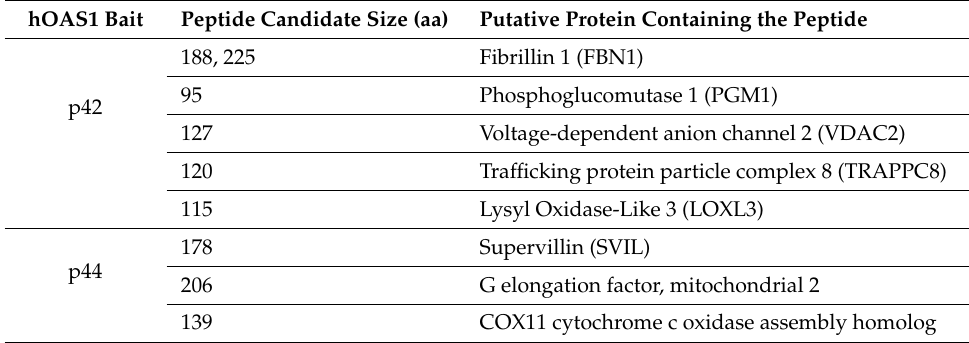
Table 1. Identification of peptide binding partners for the full-length hOAS1 p42 and p44 isoforms using a yeast two hybrid